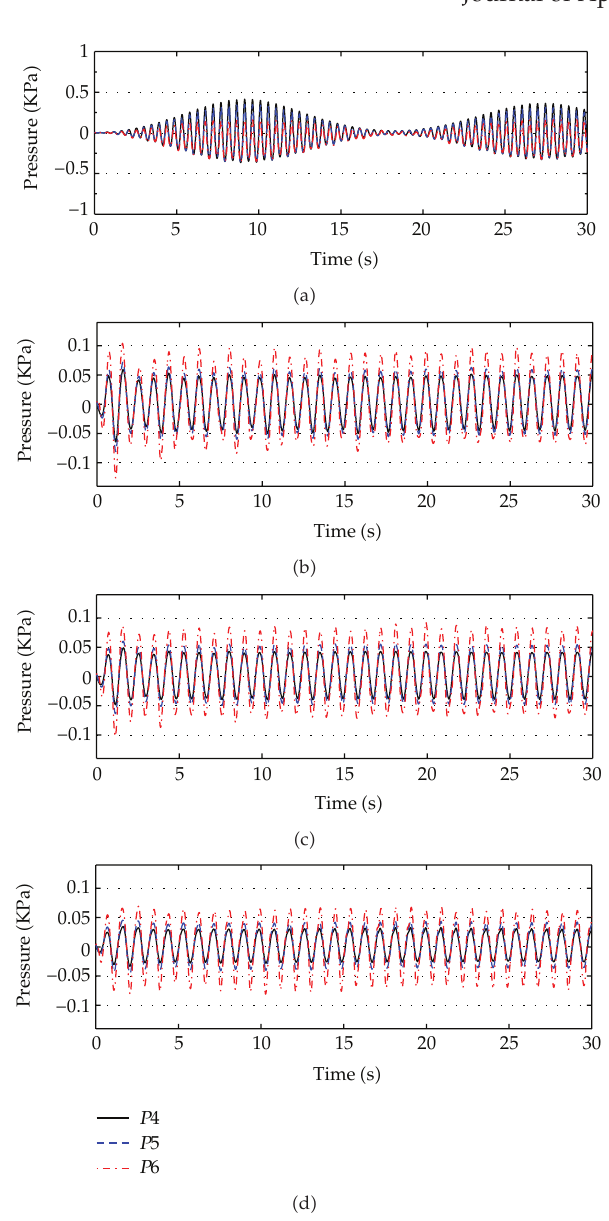
Figure 14: Dynamic pressure acting on the sidewall parallel to the motion of the tank (cid:6)(cid:6) a (cid:7) without ba ffl e; (cid:6) b (cid:7) b (cid:9) 0mm; (cid:6) c (cid:7) b (cid:9) 40mm; (cid:6) d (cid:7) b (cid:9) 80mm (cid:7)